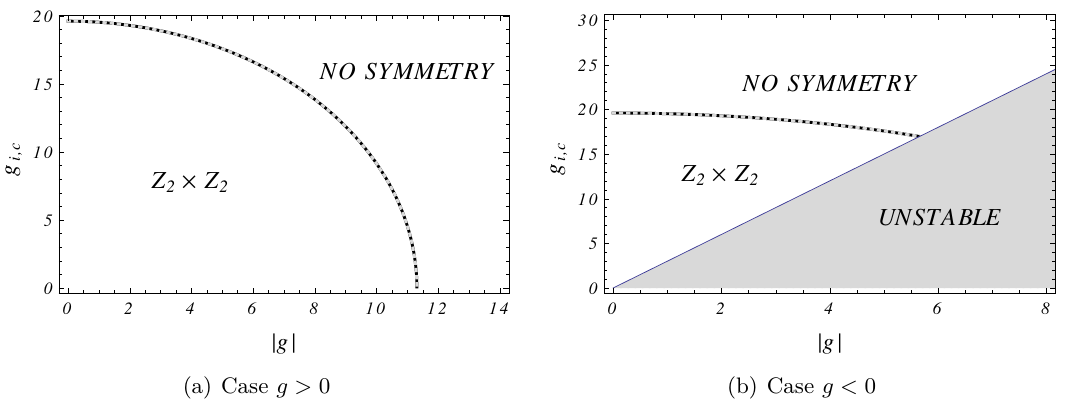
Figure 5 . Phase diagrams in the g i,c , g plane for g > 0 (panel a) and g < 0 (panel b) for the Z Z 2 × 2 symmetric model. The region labelled UNSTABLE indicates where the boundness condition g φ g χ > 9 g 2 is not obeyed. The light continuous line representing g χ,c and the dark dotted line representing g φ,c coincide indicating that conformability has been attained at the transition